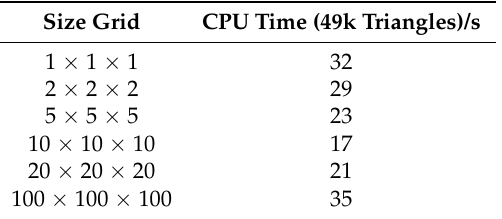
Table 3. Runtime cost for different sizes of the raytracing